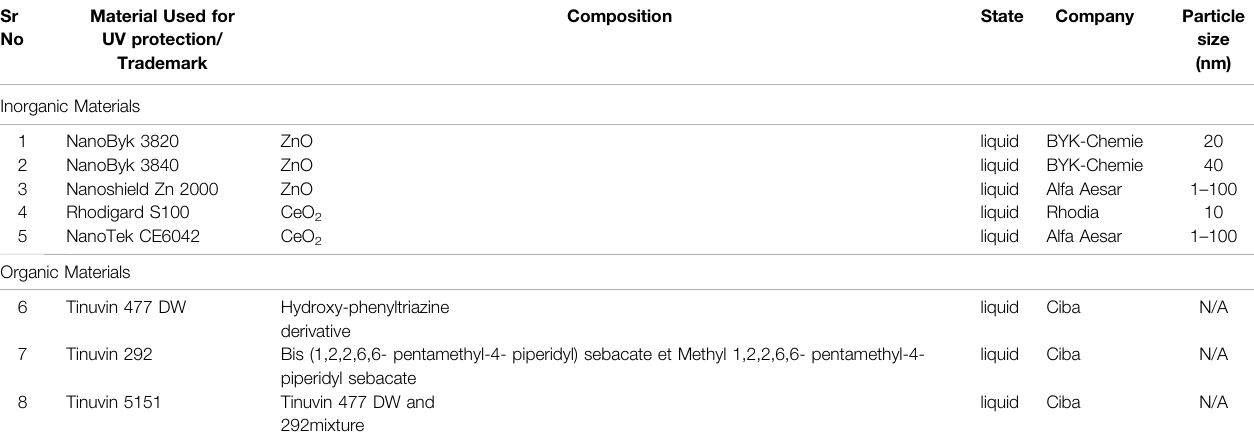
TABLE 1 | Organic and inorganic materials used in UV protective applications. Reconstructed from Blanchard and Blanchet